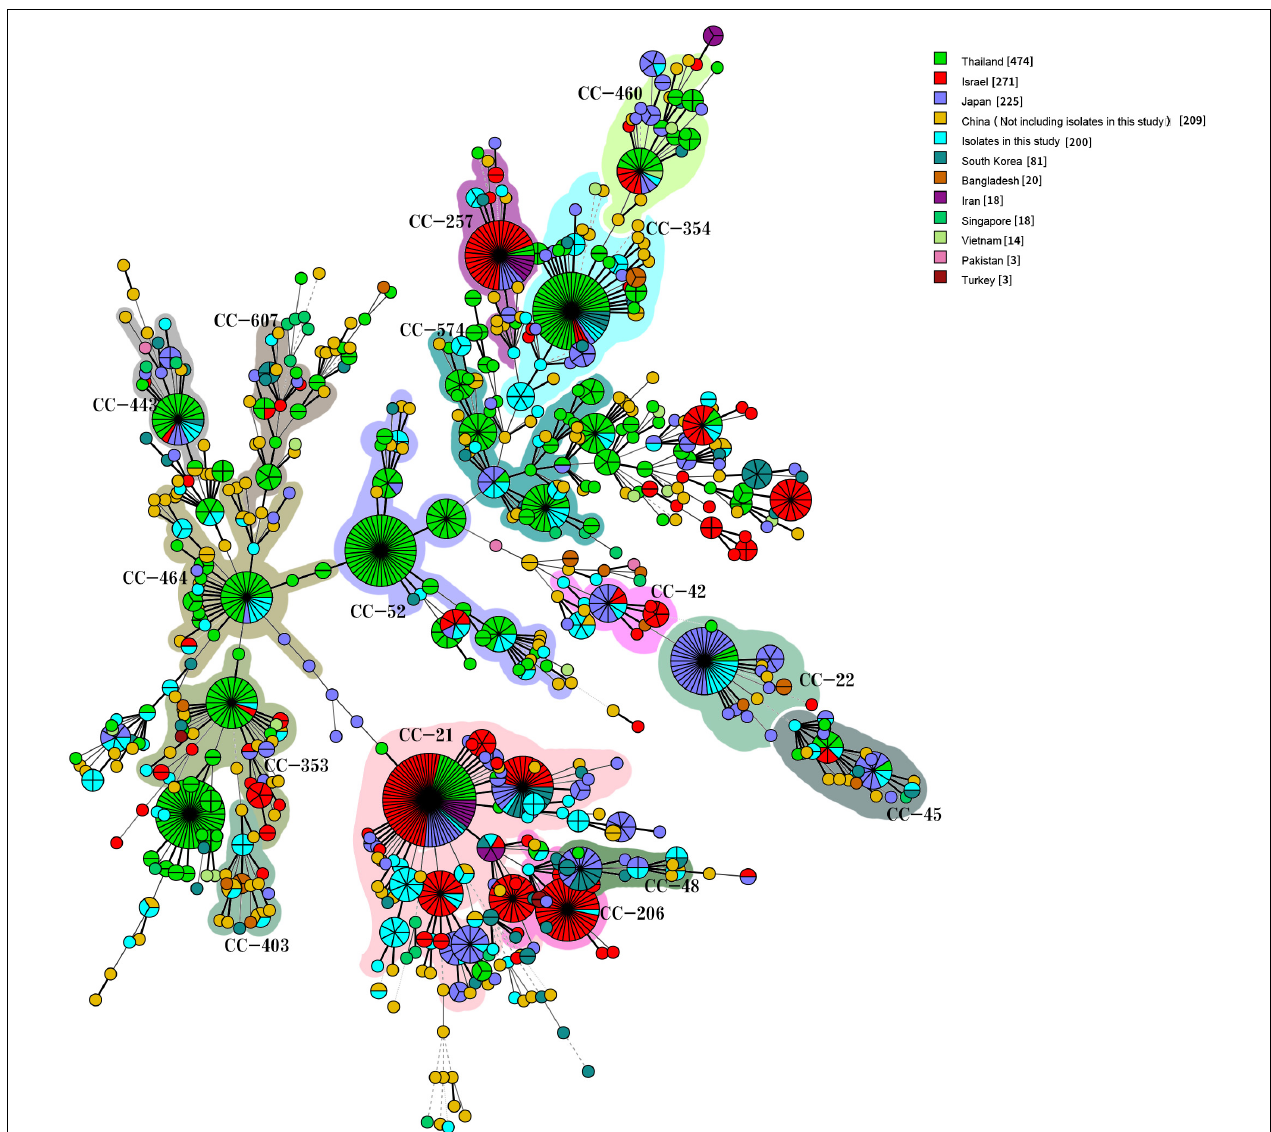
FIGURE 5 | Genetic relationships among the 200 clinical isolates C. jejuni in this study and 1,336 isolates C. jejuni from Asia in the pubmlst database (Data taken time: January 18, 2019). A minimum spanning tree was reconstructed based on CCs from this study and the MLST database. The size of circles is proportional to the number of isolates, and the sources of the isolates are colored as indicated. Shadow zones in different colors represent different clonal